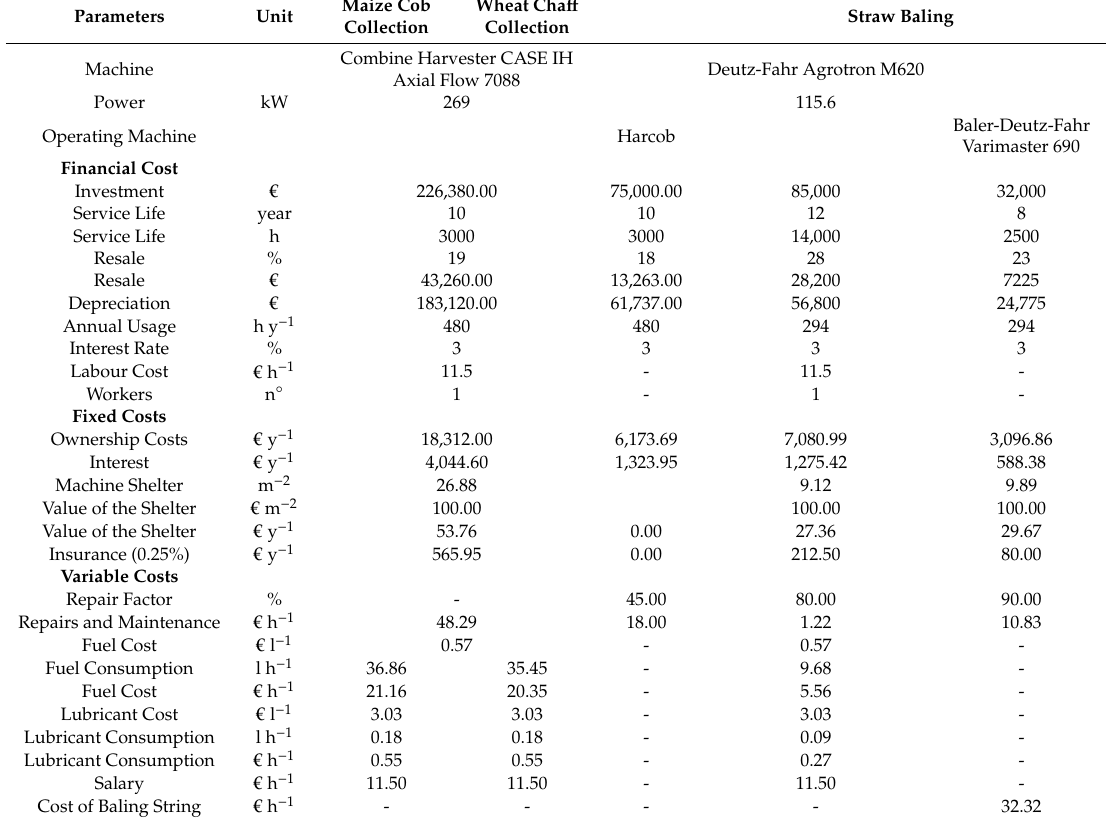
Table 2. Economic parameters used for the cost analysis of cereal straw and cha ff , and Maize cob collections using Harcob